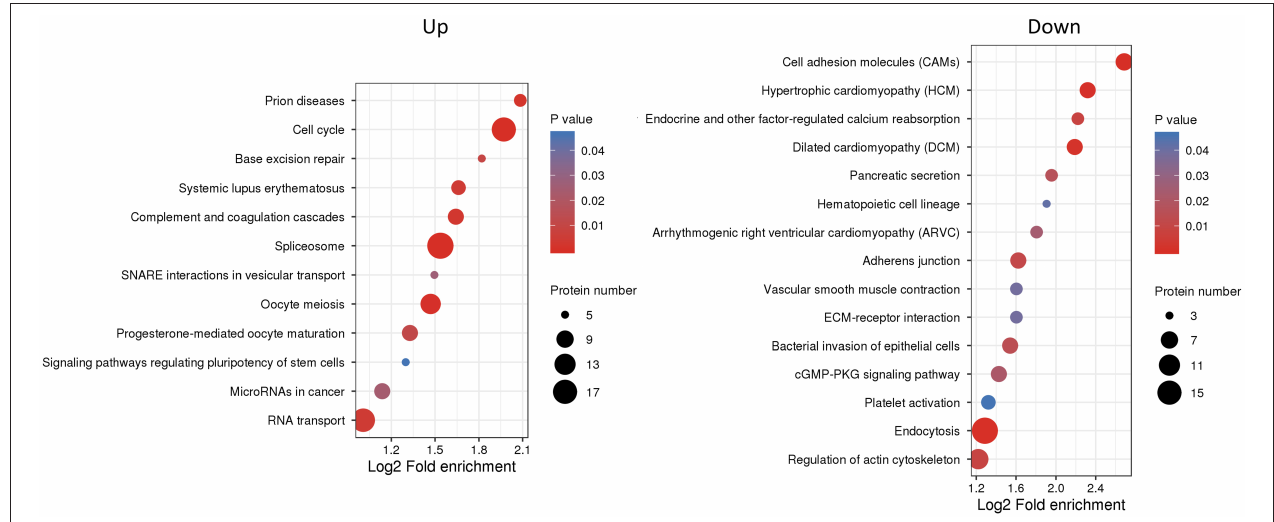
FIGURE 5 | Kyoto Encyclopedia of Genes and Genomes (KEGG) pathway enrichment analysis of differentially expressed proteins (DEPs). The P -value was calculated using a Fisher’s exact test. The X-axis represents the log2 fold enrichment, Y-axis means KEGG pathway. Bubble size corresponds to the number of DEPs for each term.